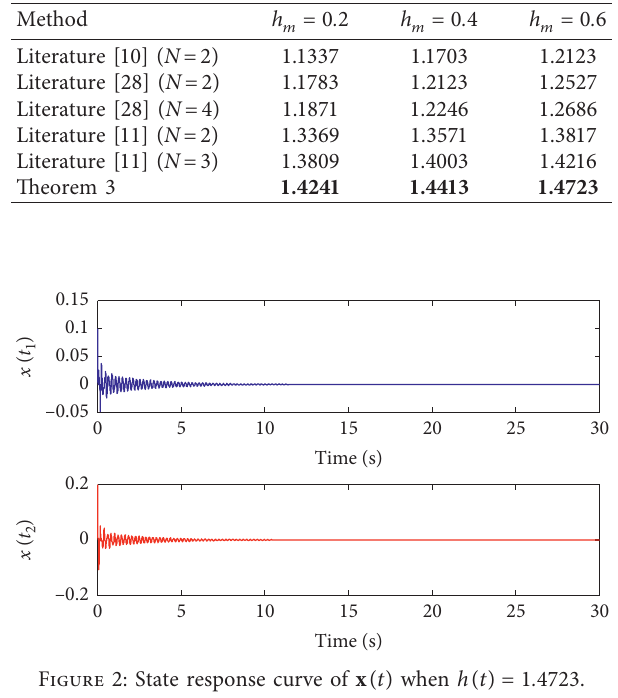
Figure 2: State response curve of x ( t ) when h ( t ) � 1 . 4723.